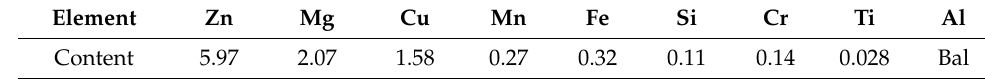
Table 1. Chemical composition of the 7075 Al alloy (wt%). Element Zn Mg Cu